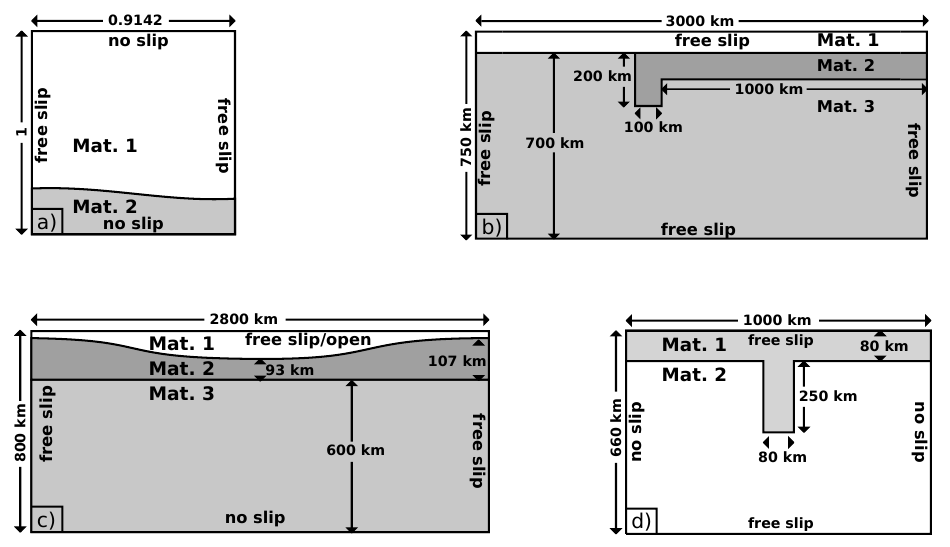
Figure 1. (a) Setup for the Rayleigh–Taylor instability benchmark: material 1 has η = 100Pas and ρ = 1010kgm − 3 and material 2 has η = 100Pas and ρ = 1000kgm − 3 . (b) Setup for the subduction benchmark: material 1 is a sticky air layer with η = 10 18 Pas and ρ = 0kgm − 3 , material 2 is a slab with η = 10 23 Pas and ρ = 3300kgm − 3 and material 3 is the mantle with η = 10 21 Pas and ρ = 3200kgm − 3 . (c) Setup for the post-glacial rebound benchmark: material 1 is a sticky air layer with η = 10 18 Pas and ρ = 0kgm − 3 , material 2 is a lithosphere with η = 10 23 Pas and ρ = 3300kgm − 3 and material 3 is the mantle with η = 10 22 Pas and ρ = 3300kgm − 3 . (d) Setup for the detachment benchmark. Material 1 is a slab with nonlinear rheology and ρ = 3300kgm − 3 and material 2 is the mantle with η = 10 21 Pas and ρ = 3150kgm − 3